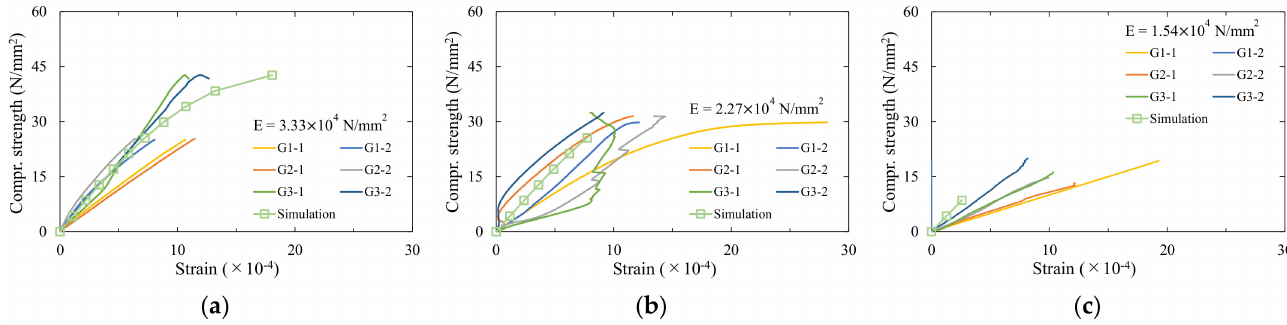
Figure 12. The stress–strain curve of 2009 SB concrete. ( a ) Conventional concrete. ( b ) SB30–63. ( c ) SB30–103.